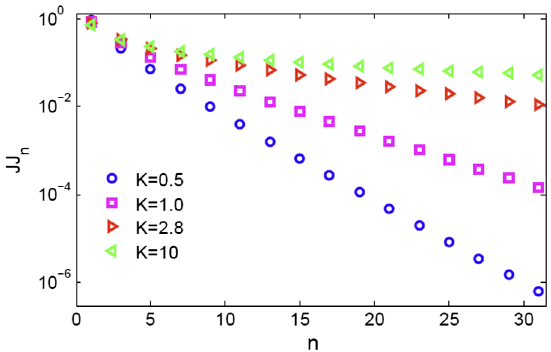
FIG. 4. Schematic layout of the harmonic interaction experi- ment at SLAC’s